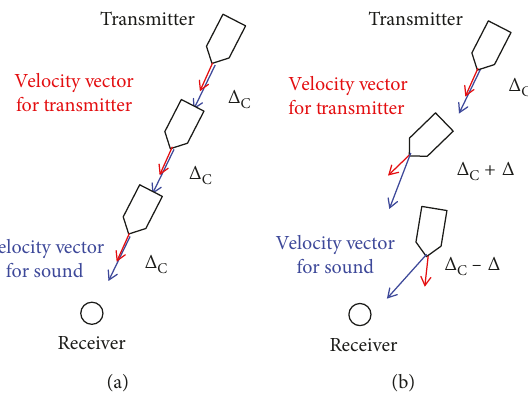
Figure 5: Doppler shift models. (a) Constant Doppler shift and (b) Doppler fluctuation.